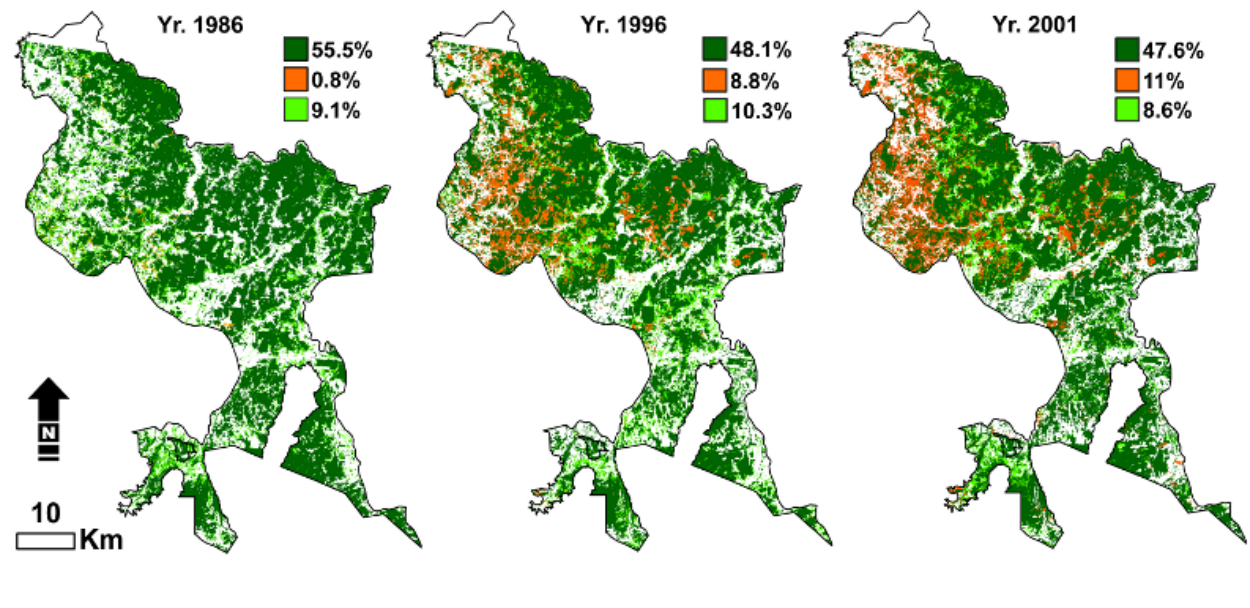
Fig. 2 . Mapped forest cover in the San Juan-La Selva Biological Corridor depicting landscape changes at each time interval using these forest categories: natural forest (dark green), forest regeneration of charral and secondary forest (bright green), and reforestation